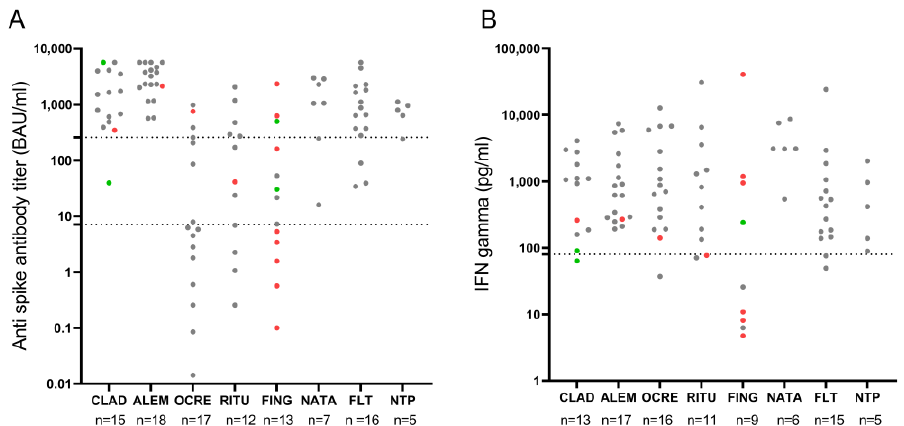
Figure 4. Post-vaccination anti-SARS-CoV-2 IgG titers ( A ) and IFN- γ levels ( B ) in relation to absolute lymphocyte counts: >800 cells/ µ L (gray dot), 500–799 cells/ µ L (red dot) and <500 cells/ µ L (green dot). ( A ) The lower dotted line marks anti-spike IgG antibody titers considered positive (7.1 BAU/mL), and the upper dotted line marks anti-spike IgG antibody titers considered protective (260 BAU/mL). ( B ) Dotted line marks IFN- γ levels of 80 pg/mL that were considered positive. ALEM: alemtuzumab; CLAD: cladribine; FING: fingolimod; FLT: first-line therapies; NATA: natalizumab; NTP: non-treated patients; OCRE: ocrelizumab; RITU: rituximab.